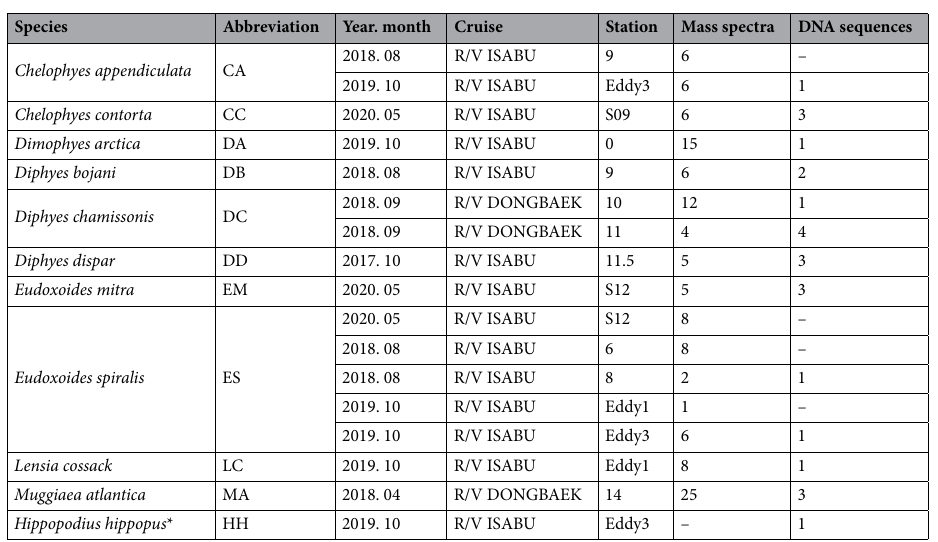
Table 2. Collecting information and the number of specimens used in the experiment to obtain DNA sequences and protein mass spectra. *